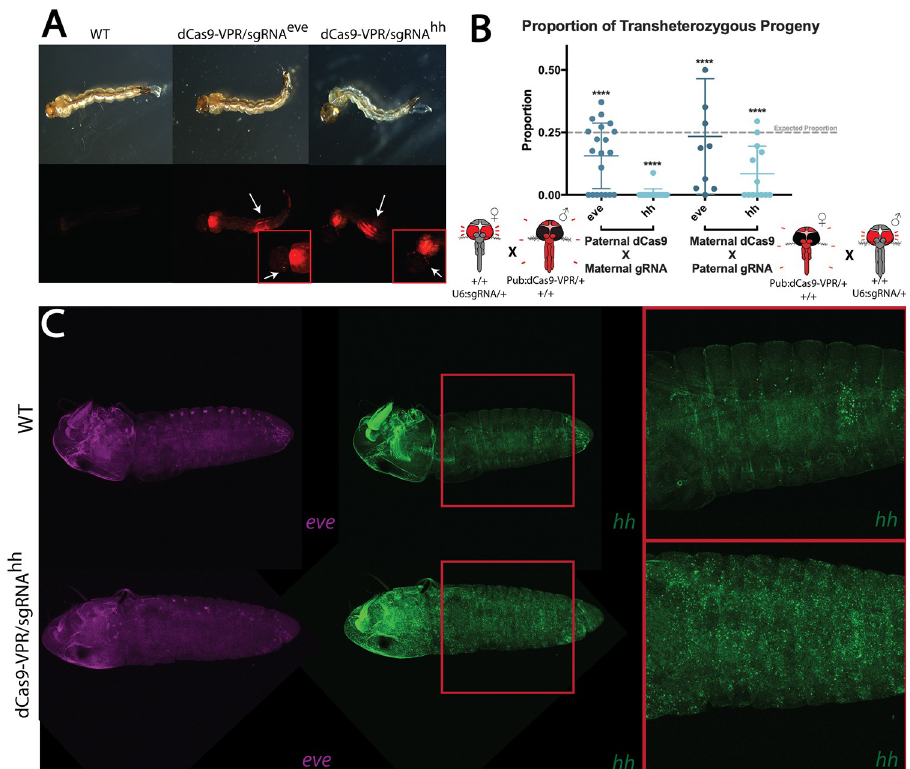
Fig 3. Phenotypic observations of CRISPRa mediated transactivation of eve and hh . A) Surviving transheterozygous progeny were collected and showed no significant external morphological differences to wild-type larvae. B) The proportions of transheterozygous progeny were calculated from single pair crosses between heterozygous dCas9-VPR and sgRNA parents. Rates of inheritance were compared to an expected rate of Mendelian inheritance, 25% transheterozygous individuals among total offspring, using a Chi-square test ( ���� p < 0.0001). C) Further imaging of HCR in situ hybridization of hh probes showed upregulated and misregulated expression of hh compared to WT, while eve expression stayed relatively the same as that of